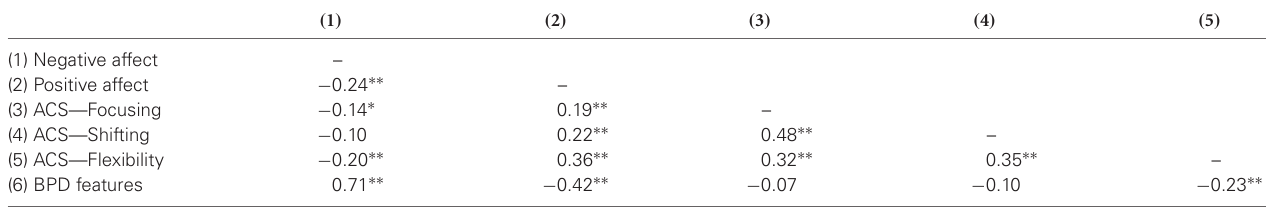
Table 2 | Correlations between measurement scale scores .